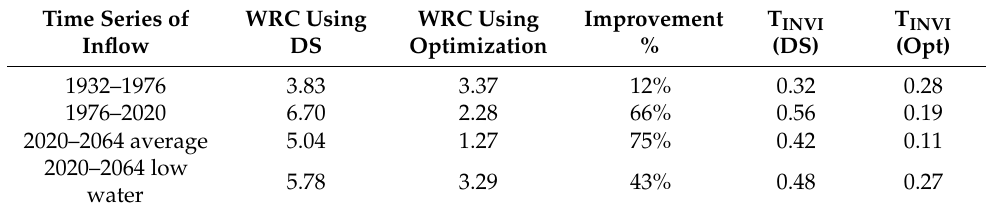
Table 3. Values of the INRI indicator for the eight performed